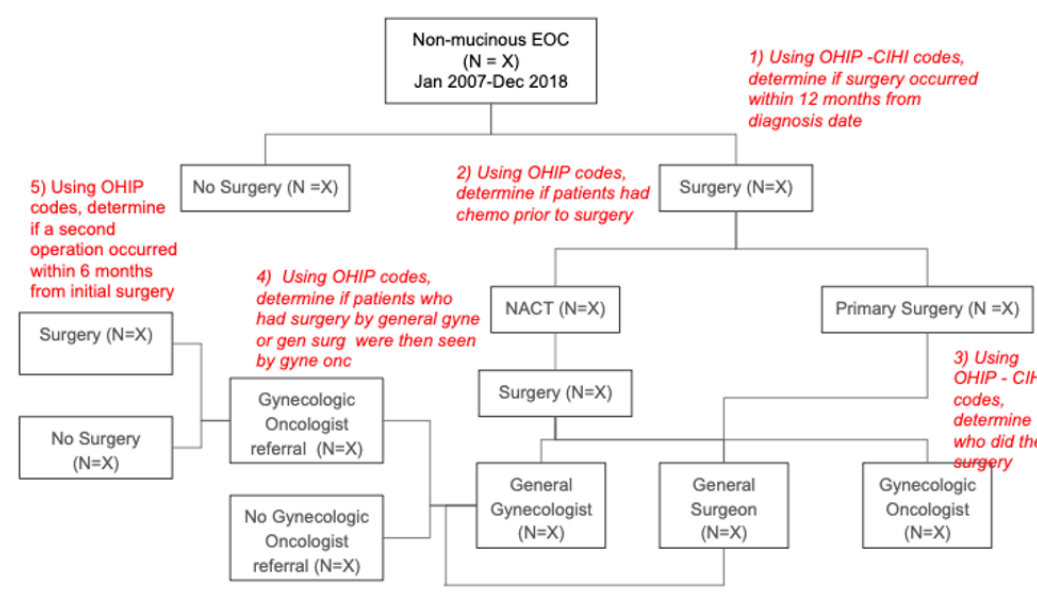
Figure A2. Initial cohort creation algorithm. Adapted from G. Bouchard-Fortier data creation plan (initial cohort).